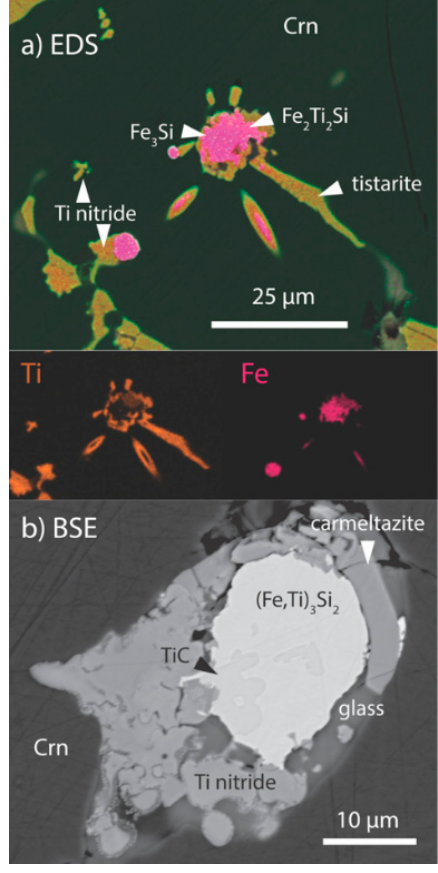
Figure 7. ( a ) BSE image with Ti and Fe maps, of a branching Ti nitride lens with immiscible blebs of Fe silicide across the center. Note emulsion rims on vertical branches in contact with silicate glass, but not against tistarite. ( b ) BSE image of Fe–Ti–silicide spheroid in a melt pocket, which also contains khamrabaevite (TiC), carmeltazite and irregular blobs of Ti nitride; the microstructures suggest the presence of three immiscible melts. Crn, corundum.